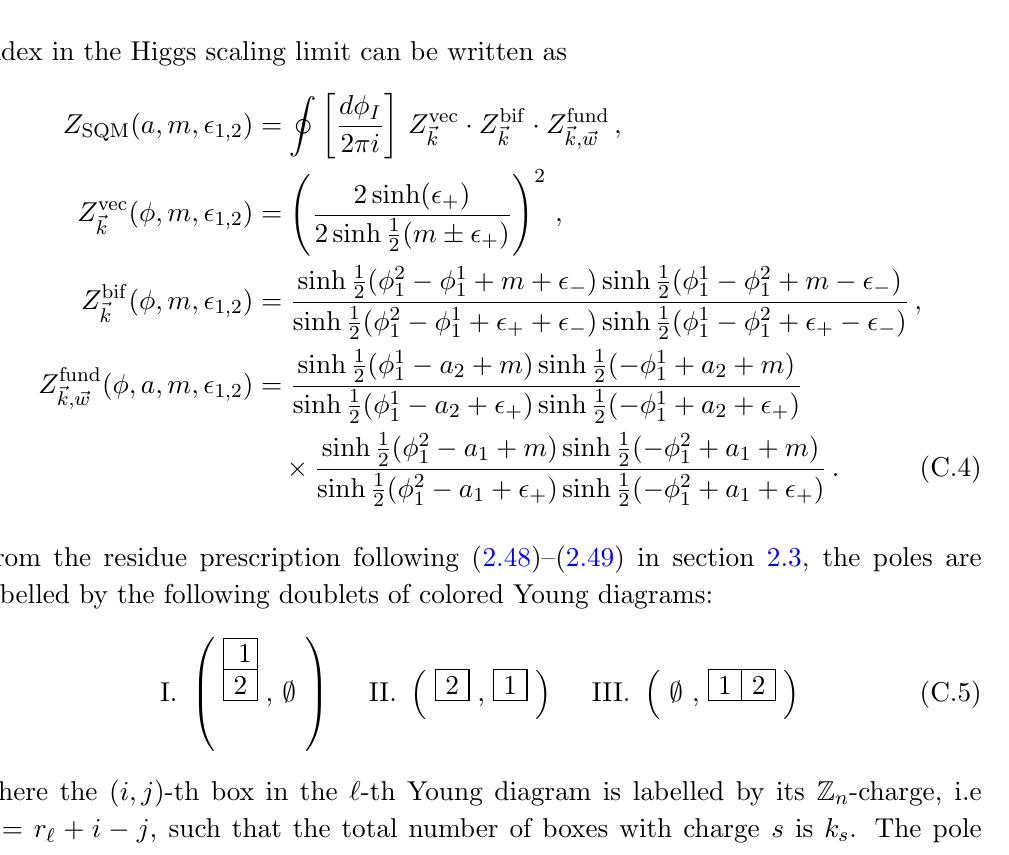
Table 2 . Summary table for examples of quiver SQMs associated with the monopole bubbling indices of ’t Hooft operators in N = 2 (cid:3) SU(2)